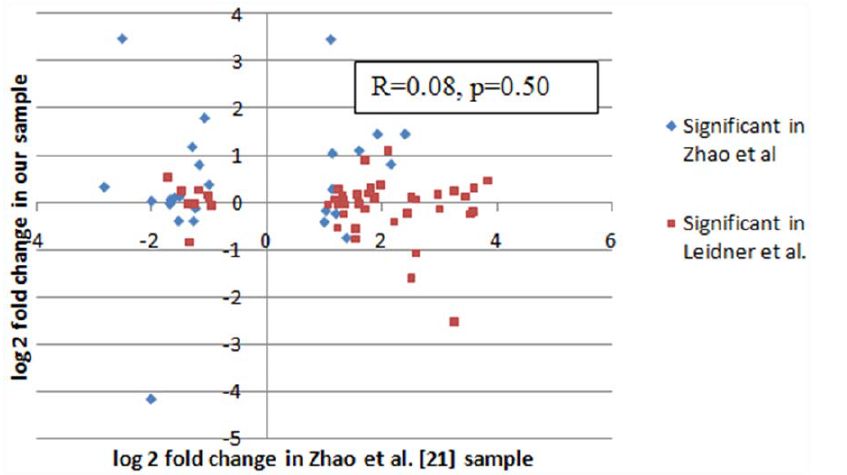
Figure 3. Lack of outliers correlation in fold change between our and Zhao et al. datasets miRNAs significant in one or both samples. Correlation in fold change for miRNAs significantly different between breast cancer cases and controls as observed in one, or both, studies (n=72).